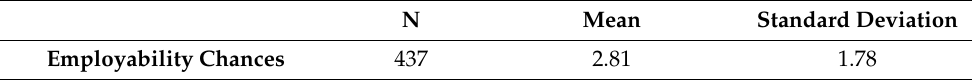
Table 6. Mean score of frequency of employability chances based on existing skills set. N